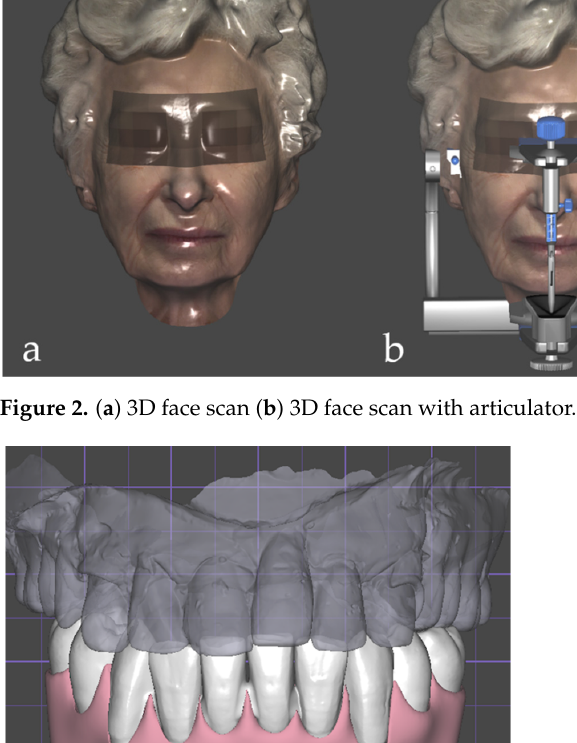
Figure 4. Implant positioning and osteotomy plan. A tooth-supported positioning template was created with two functions: to guide the positioning of the anchor pins for the implant template and to provide a reference to the surgeon during the execution of the osteotomy through the slit included in the lower part (Figure 5a). The creation of this template is essential, since once the extractions and the osteotomy have been performed, all the landmarks used during the design phase will be lost; therefore, only the anchor pins will guide the positioning of the implant template. At this point, the implant template is designed with the same anchor pins (Figure 5b,c). Once the STL files of both templates had been created, the data were sent to a 3D Printer (Moonray S, SprintRay Inc ® , Los Angeles, CA, USA) (Figure 6). The templates were printed with KeyGuide resin (KeyPrint ® , Singen, Germany). The printing process lasted for 90 min; afterwards, both templates were cleaned in an ultrasonic bath filled with isopropyl alcohol for 10 min, dried, and cured for 20 min with UV light at a temperature of 60 °C.